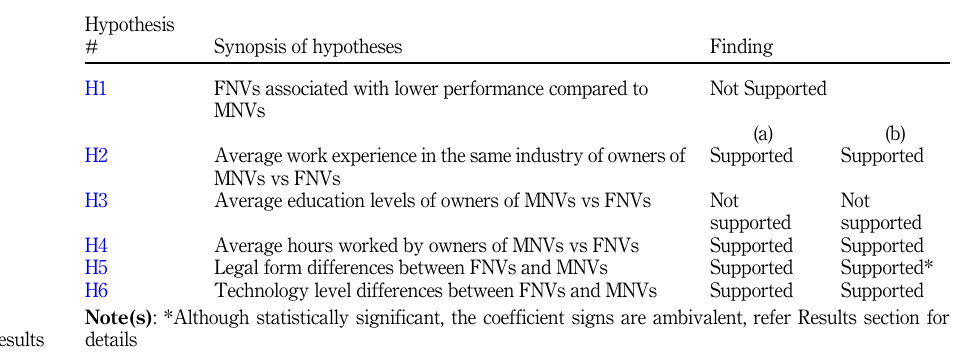
Table 5. Oaxaca decomposition analysis